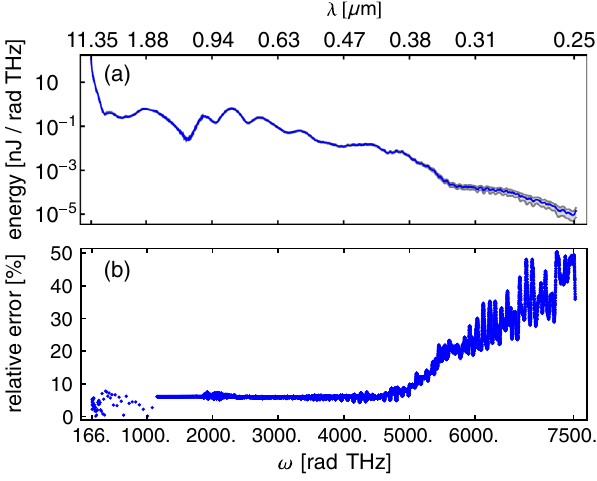
(depicted in gray) indicates a standard deviation of the mean. It is separately shown on the bottom of Fig. 20 as a function of frequency. In the error analysis, the contribution of the uncertainties of the wavelength calibration and relative calibration from each partial spectra as well as the contribution of the absolute calibration uncertainties from the NIR spectrum are taken into account.